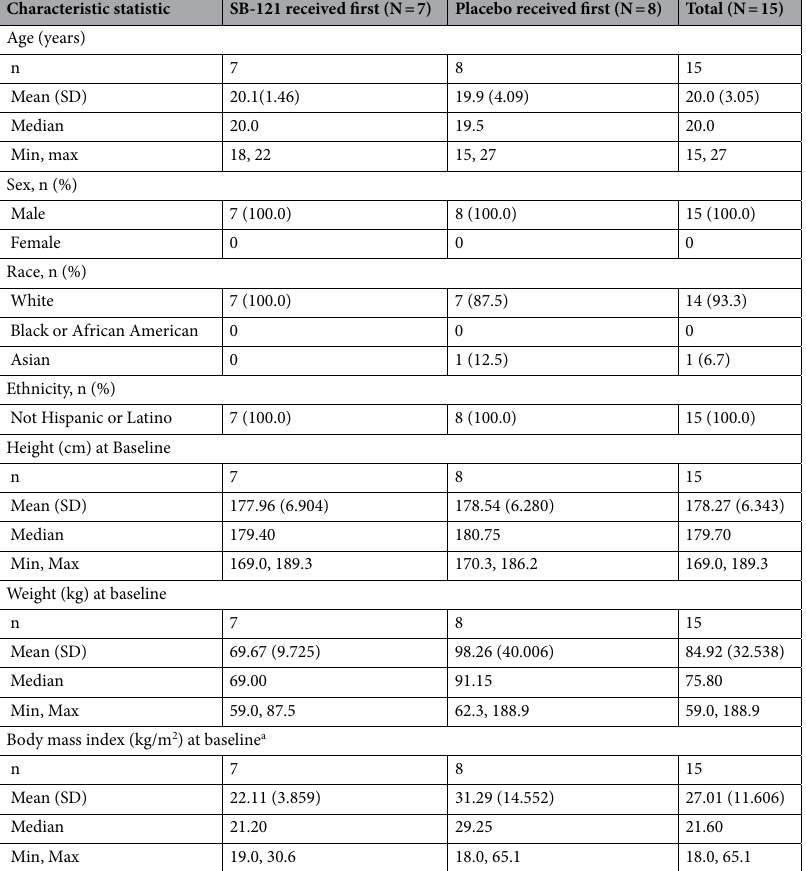
Table 1. Summary of demographic and baseline characteristics (intent to treat population). ADOS-2 Autism Diagnostic Observation Schedule, 2nd edition, max maximum, min minimum, n number of participants with data available, N number of participants according to the first treatment sequence, SD standard deviation, % percentages were calculated based on N as the denominator. Baseline was considered the last observation prior to dosing in Treatment Period 1. Drug abuse was considered positive if at least one of the parameters of drug abuse was positive and it was considered negative if all parameters of drug abuse were negative. a Body mass index (kg/m 2 ) = body weight (kg)/height (m 2